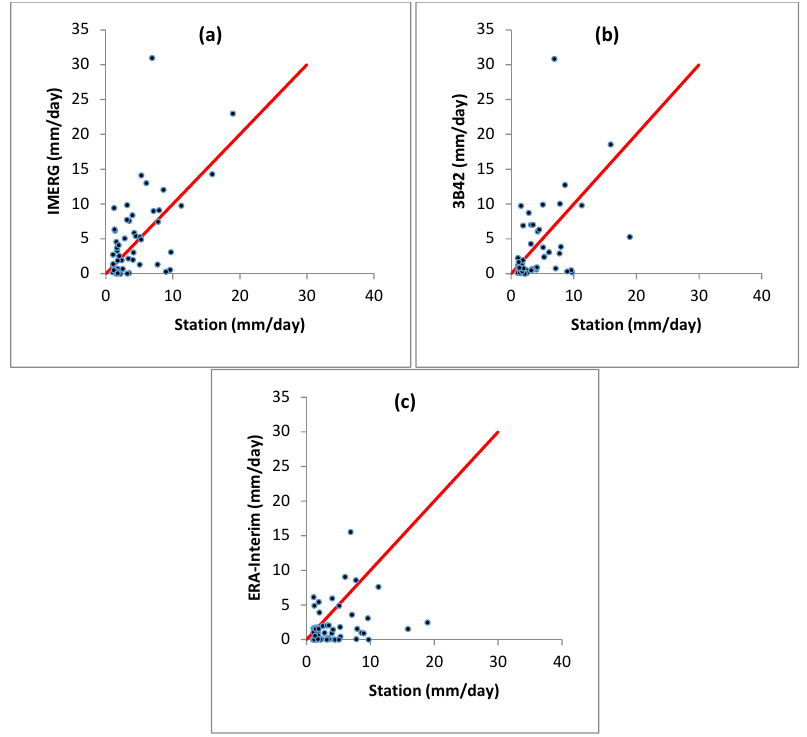
Figure 6. Daily precipitation events scatter plots for Kermanshah of IMERG ( a ); 3B42 ( b ) and ERA-Interim ( c ) against gauge data (mid-March 2014 to February 2015).